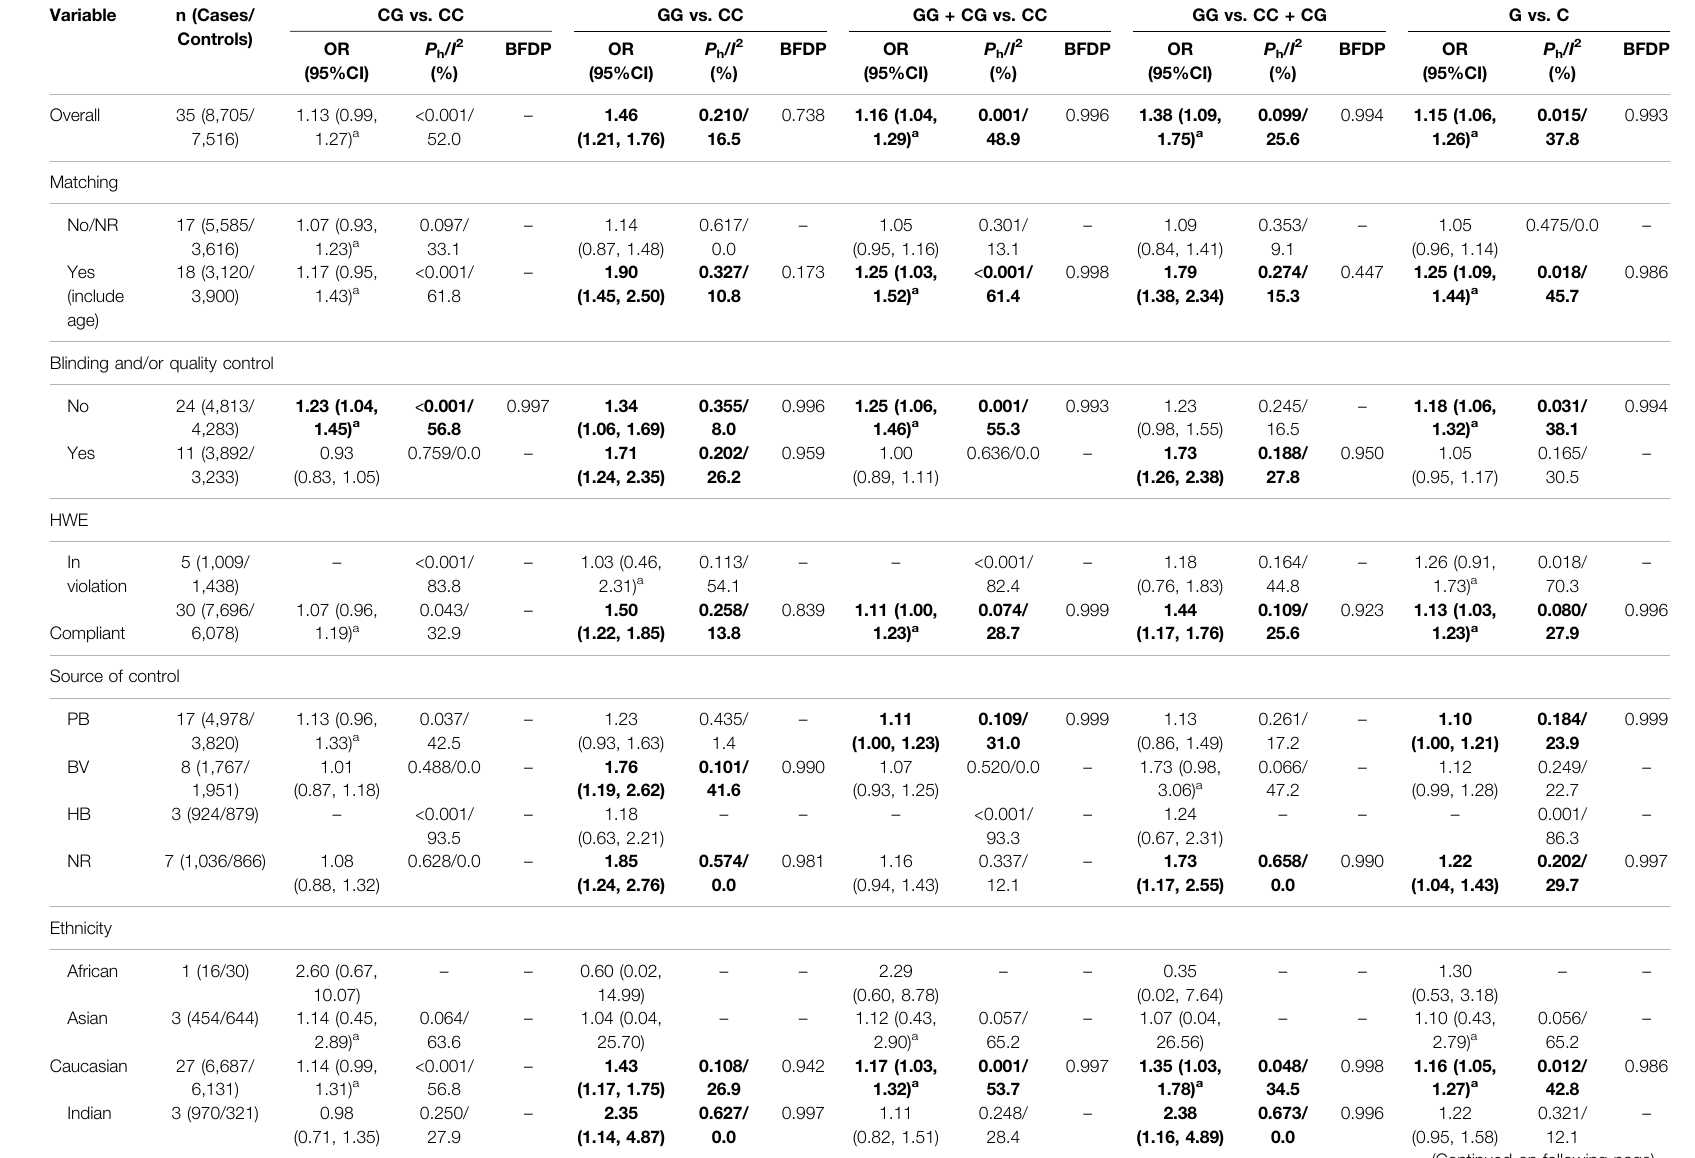
TABLE 3 | Pooled results on the association between the TP53 IVS3 16bp (rs17878362) polymorphism and BC risk.